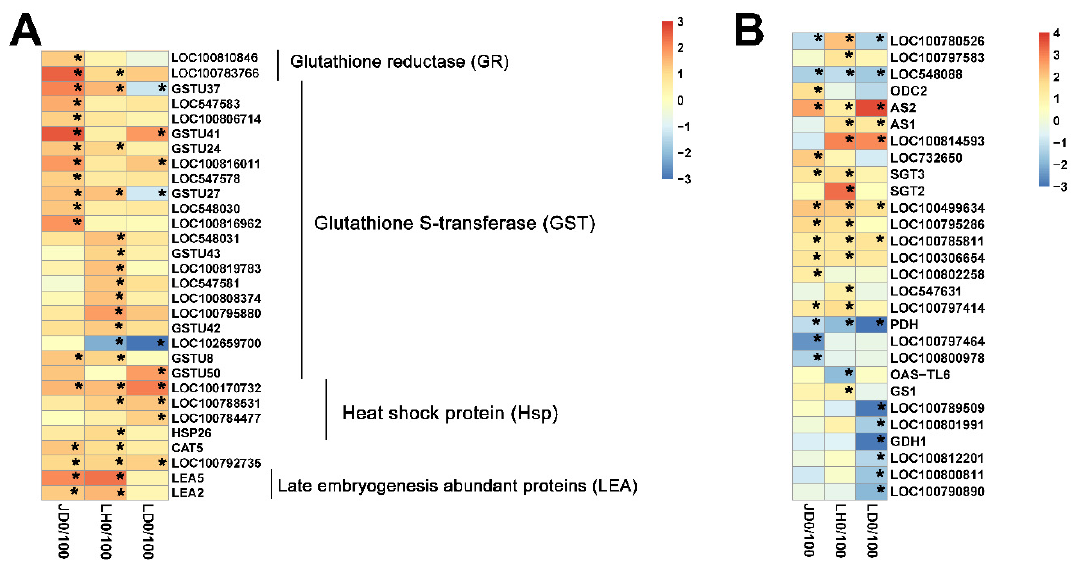
Figure 4. Heatmap of glutathione metabolism and stress response metabolism ( A ), amino acid metabolism ( B )-related genes in three soybean cultivars under 100 mM NaCl treatment. Color panels display the Log2 fold change. Asterisks indicate the significant difference with an FDR < 0.01 and fold change ≥ 2.